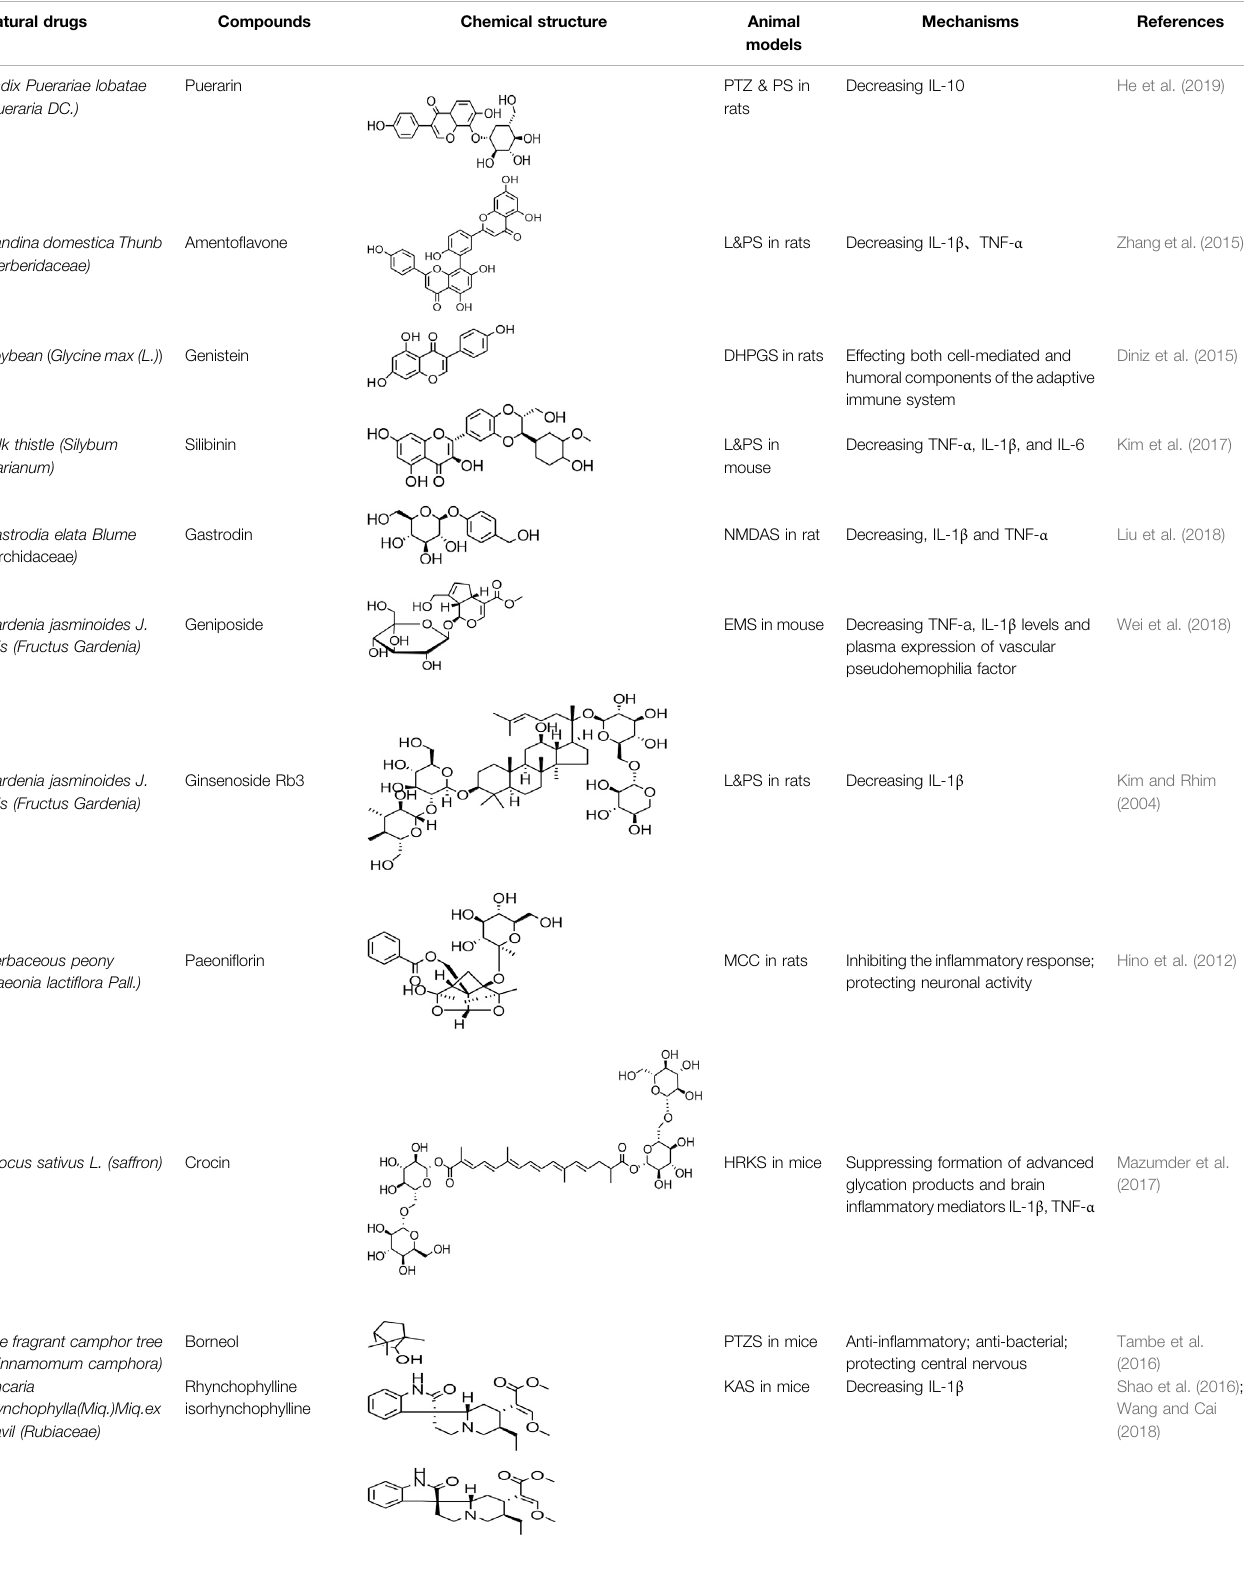
TABLE 4 | Natural drugs that treats epilepsy by regulating the immune system and in fl ammatory